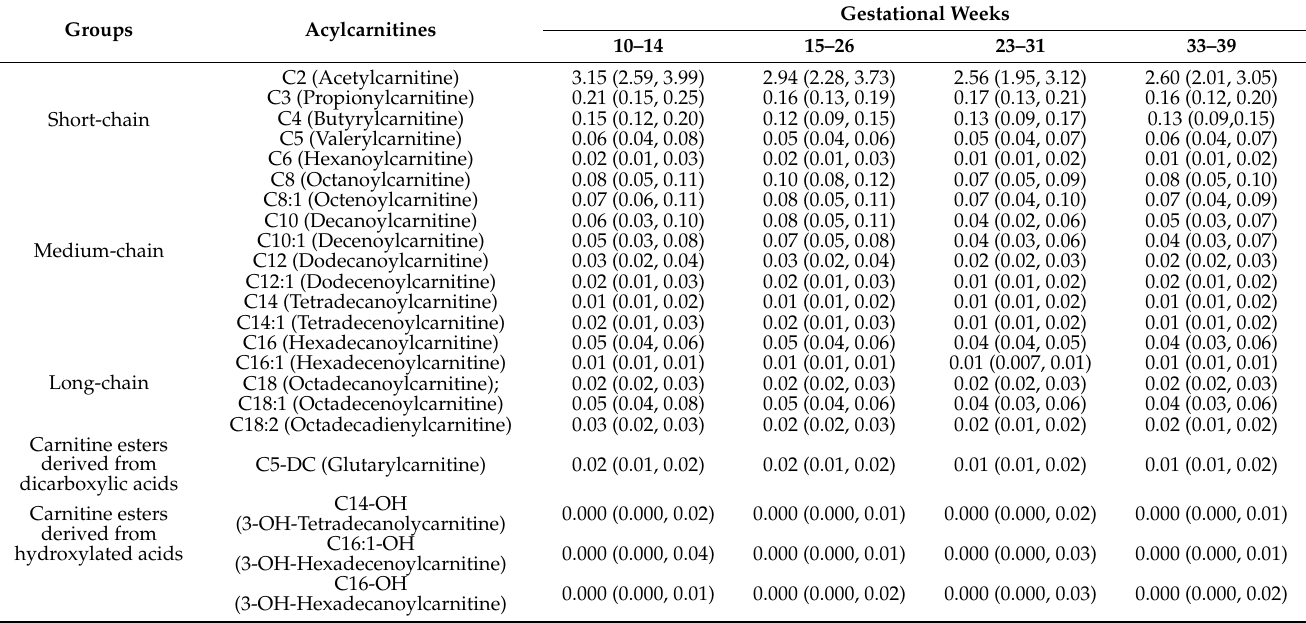
Table 3. Median and interquartile range (IQR) of 22 acylcarnitines ( µ mol/L) by four